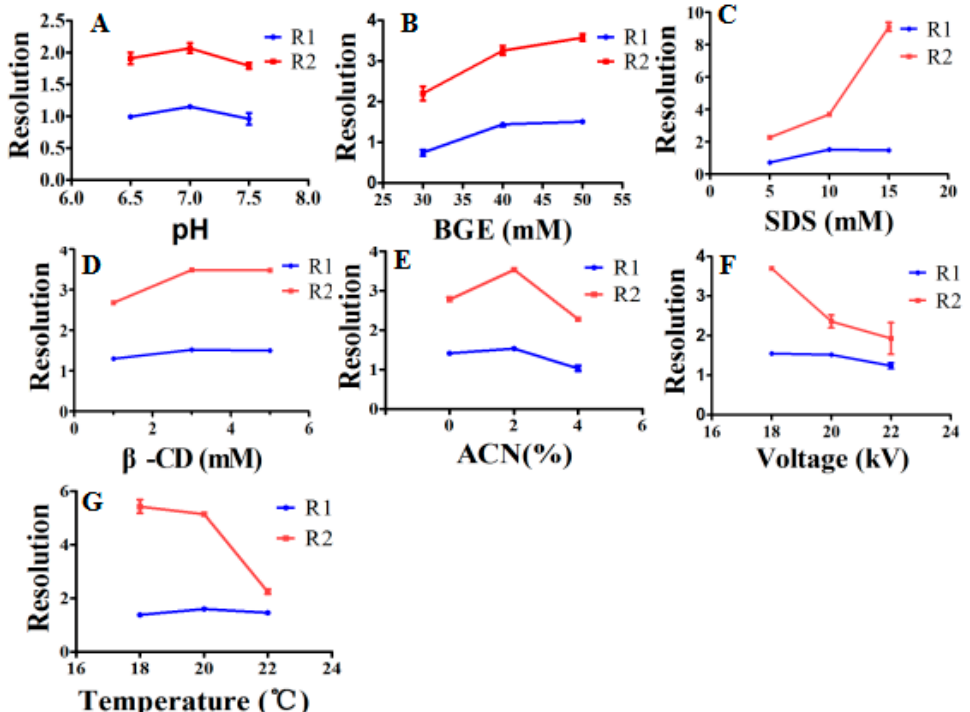
Figure 2. The effects of parameters on R1 and R2.;( A ) The effect of buffer pH on R1 and R2, ( B ) the effect of buffer concentration on R1 and R2, ( C ) the effect of SDS concentration on R1 and R2, ( D ) the effect of β -CD concentration on R1 and R2, ( E ) the effect of acetonitrile concentration on R1 and R2, ( F ) the effect of voltage on R1 and R2, ( G ) the effect of temperature on R1 and R2.. (R1: The resolution of kaempferol-3-rutinoside and narcissoside; R2: The resolution of [Fe(ferrozine) 3 ] 2+ and quercetin)